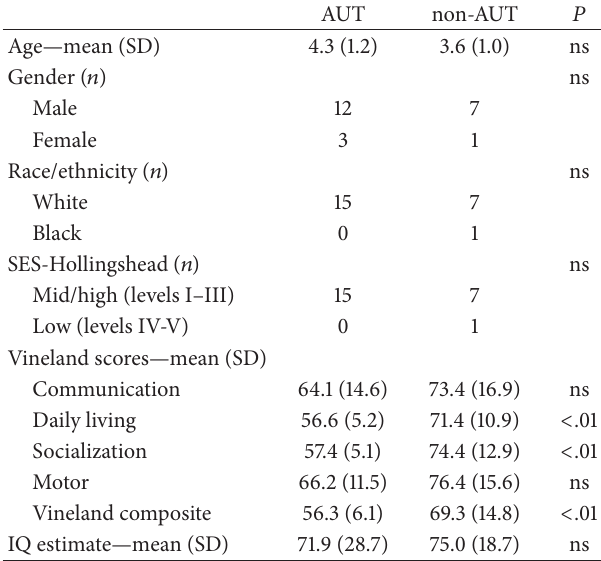
Table 1: Characteristics of the children in the autistic (AUT) and nonautistic (non-AUT)